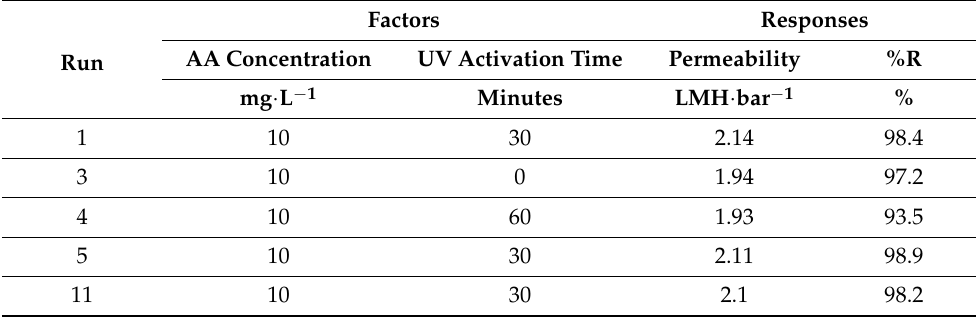
Table 3. Effect of UV exposure on membrane permeability and salt rejection.